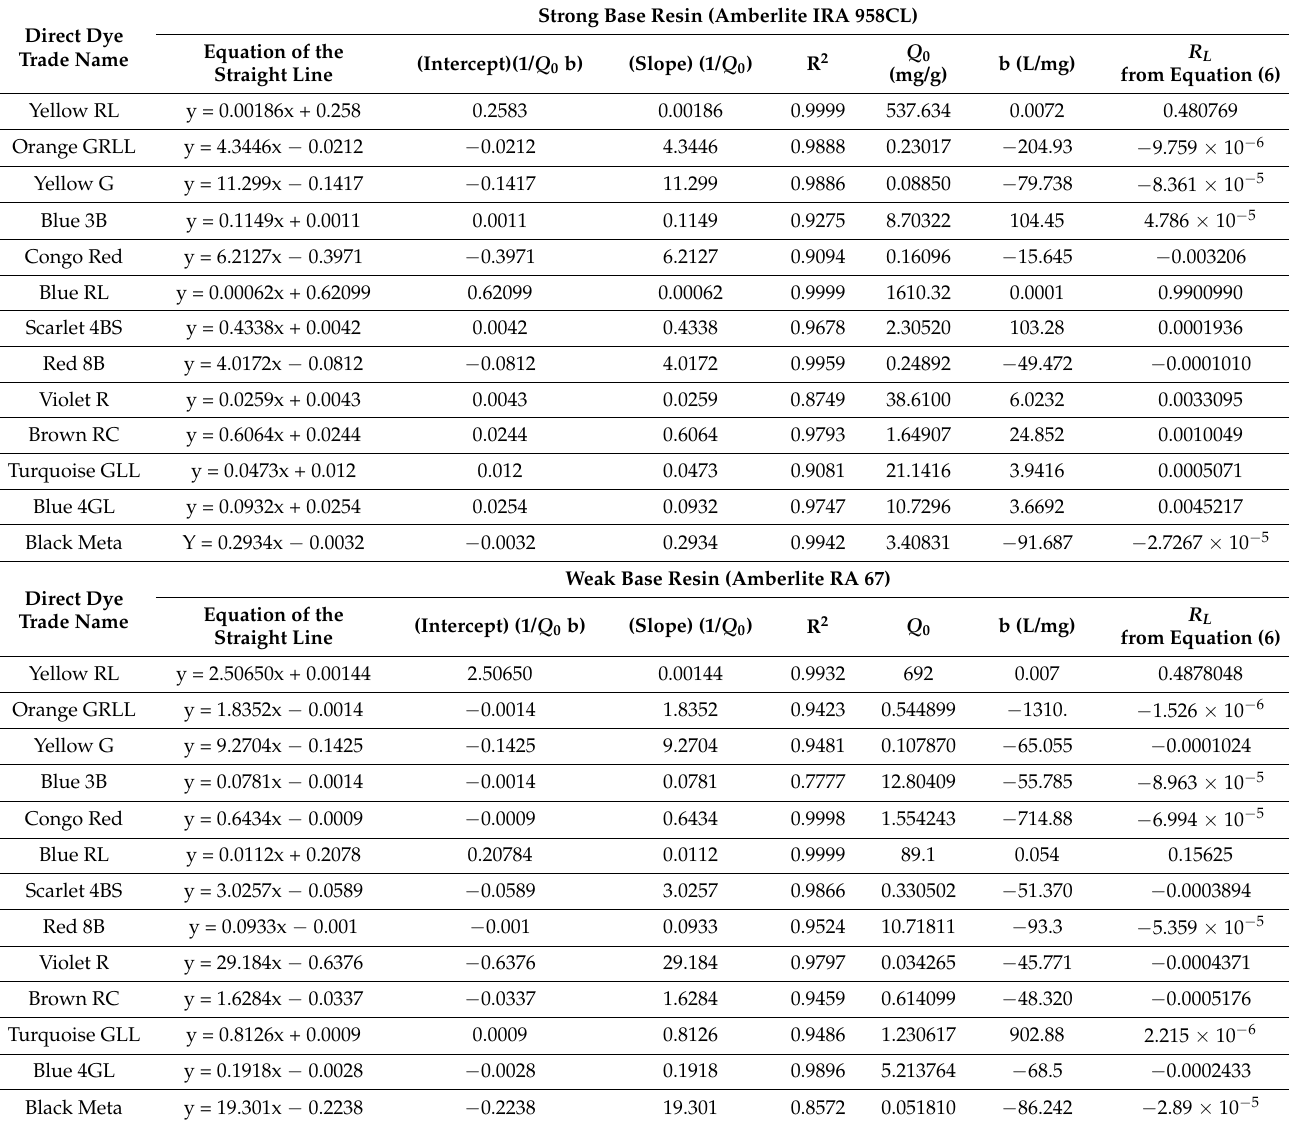
Table 7. Equations, values of slope, and intercept for Langmuir